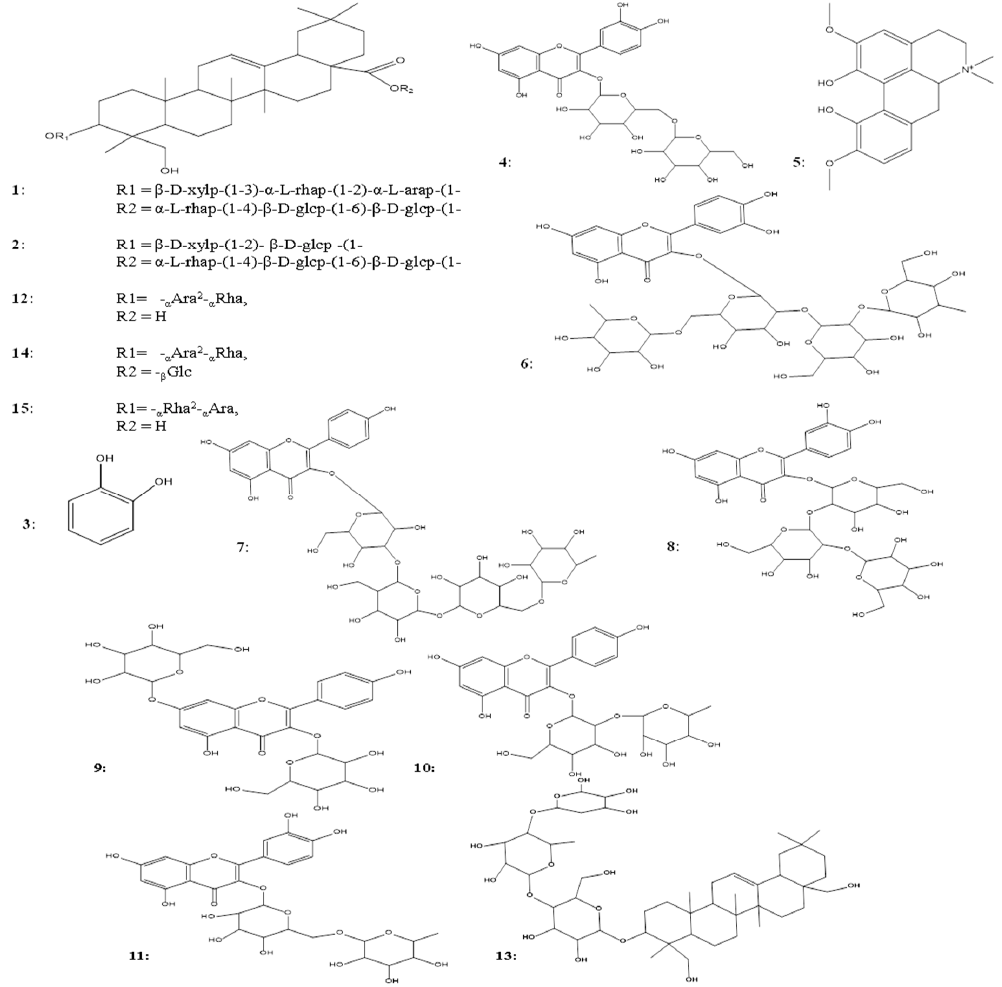
Figure 2. Molecular structures of isolated compounds from Nigella sativa. 3-O-[ β - D -xylopyranosyl-(1- 3)- α - L -rhamnopyrnaosyl-(1-2)- α - L -arabinopyranosyl]-28-O-( α - L -rhamnopyrnaosyl-(1-4)- β - D -gluco- pyranosyl-(1-6)- β - D -glucopyranosyl]hederagenin ( 1 ), flaccidoside III ( 2 ), catechol ( 3 ), quercetin-3- gentiobioside ( 4 ), magnoflorine ( 5 ), nigelflavonoside B ( 6 ), nigelloside ( 7 ), quercetin sphorotrioside ( 8 ), kaempferol-3,7-diglucoside ( 9 ), kaempferol 3-O-rutinoside ( 10 ), rutin ( 11 ), 3-O-[ α - L - rhamnopyranosyl-(1 → 2)- α - L -arabinopyranpsyl]hederagenin ( 12 ), 3 β ,23,28-trihydroxyolean-12-ene 3- O- α - L -arabinopyranoside (1 → 4)-a- L -rhamnopyranosyl (1 → 4)- β - D -glucopyranoside ( 13 ), 3-O-[ α - L - rhamnopyranosyl-(1 → 2)- α - L -arabinopyranpsyl]-28-O- β - D -glucopyranosylhederagenin ( 14 ), α - hederin ( 15 ).